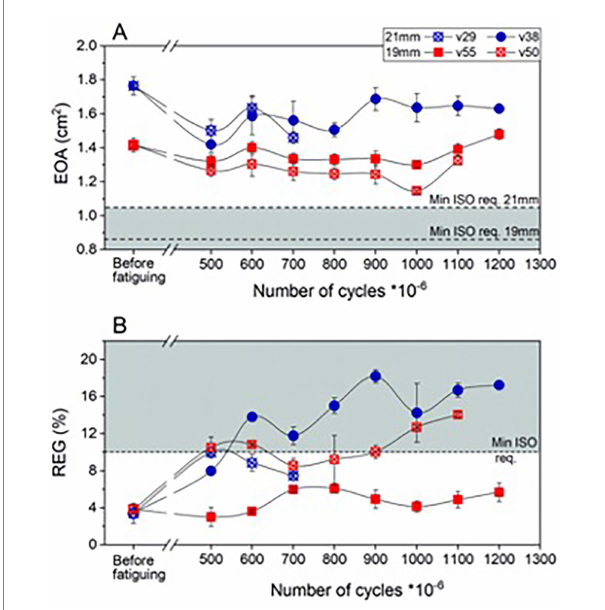
FIGURE 4 Hydrodynamic performance of fatigued PoliValve prototypes of various iterations. (A) Effective orifice area (EOA); (B) regurgitant fraction (REG). Durability testing performed over 1.3 billion